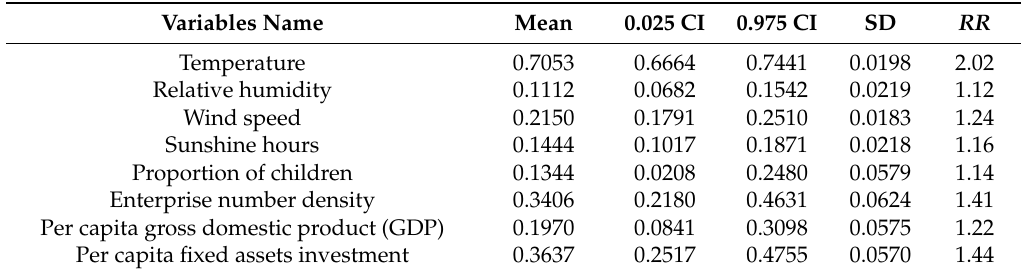
Table 2. Estimated posterior parameters and relative risk ( RR ) values of the climate and socioeconomic risk factors on HFMD